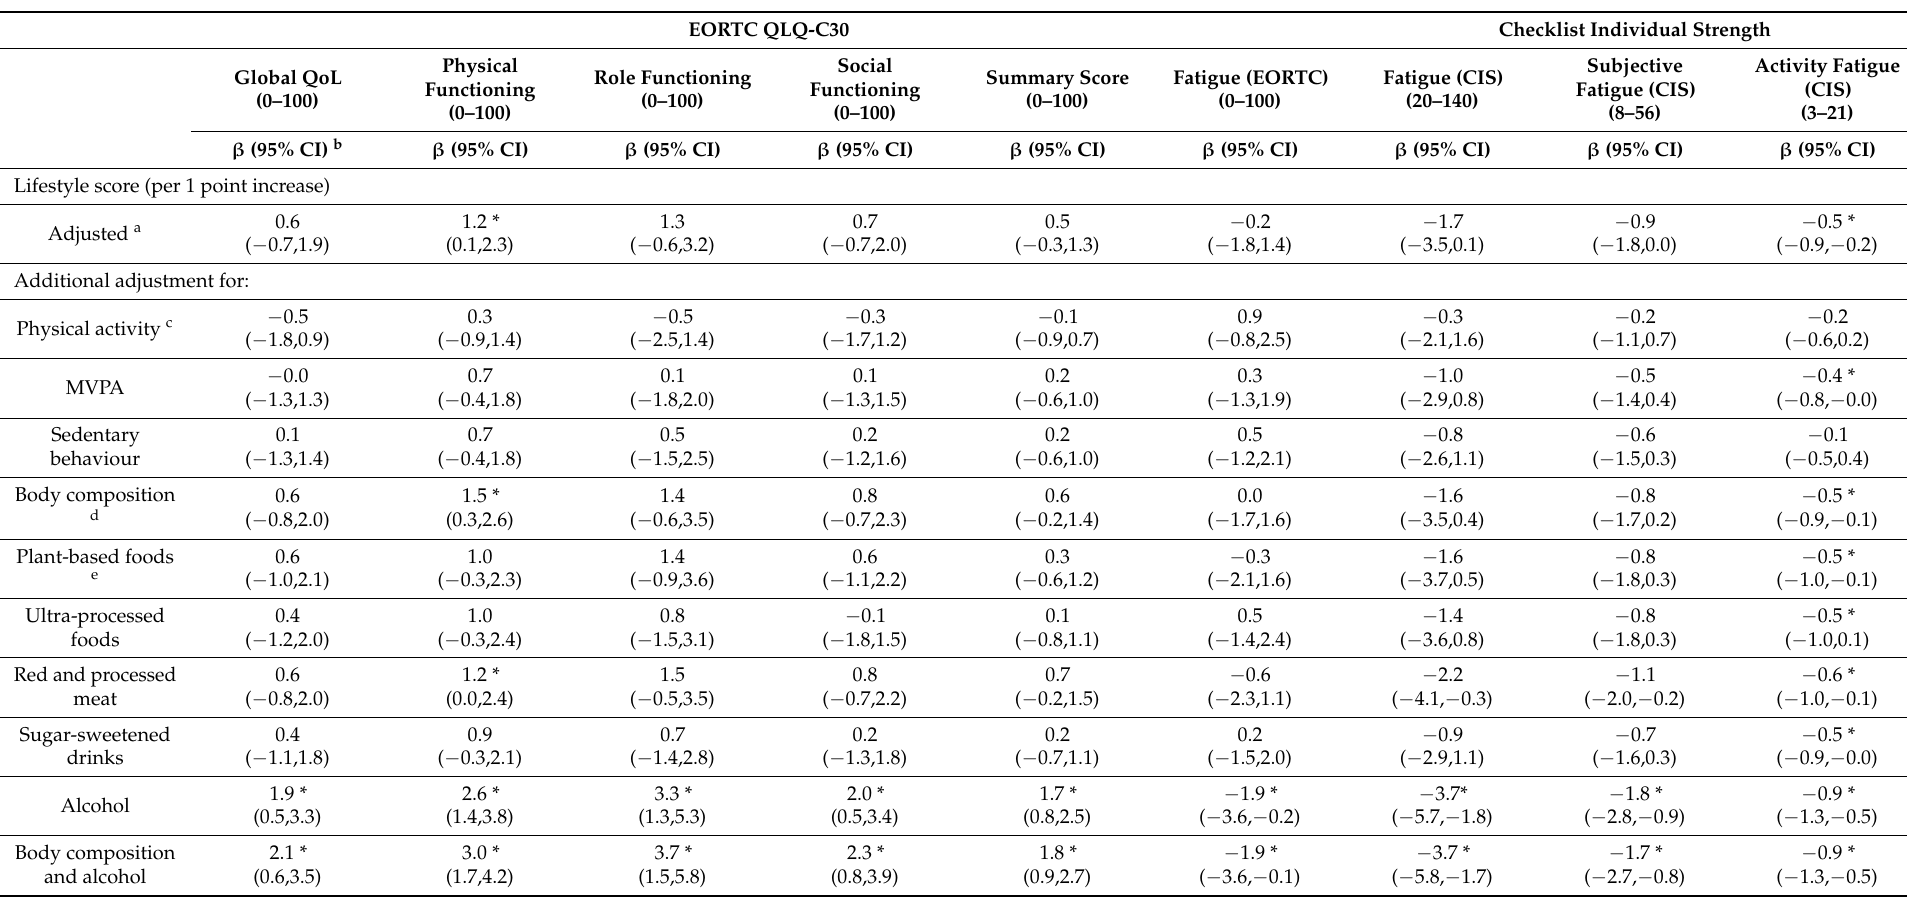
Table 3. Linear mixed models between the lifestyle score in relation to health-related quality of life and fatigue, both overall and adjusted for the individual WCRF/AICR lifestyle recommendation